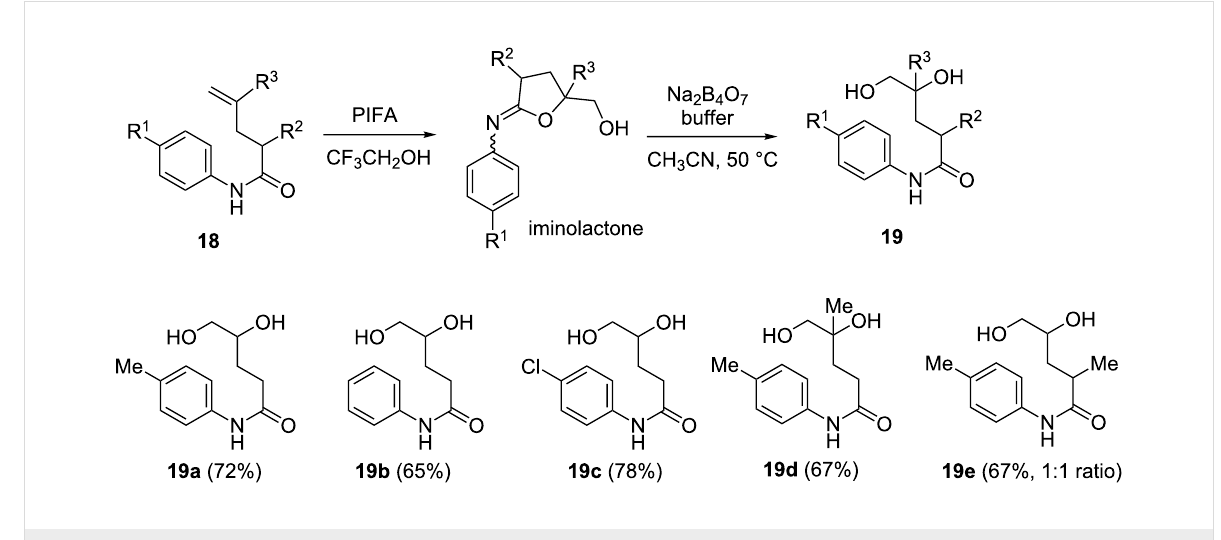
Figure 1: Hydrolysis of iminolactone 18 under basic